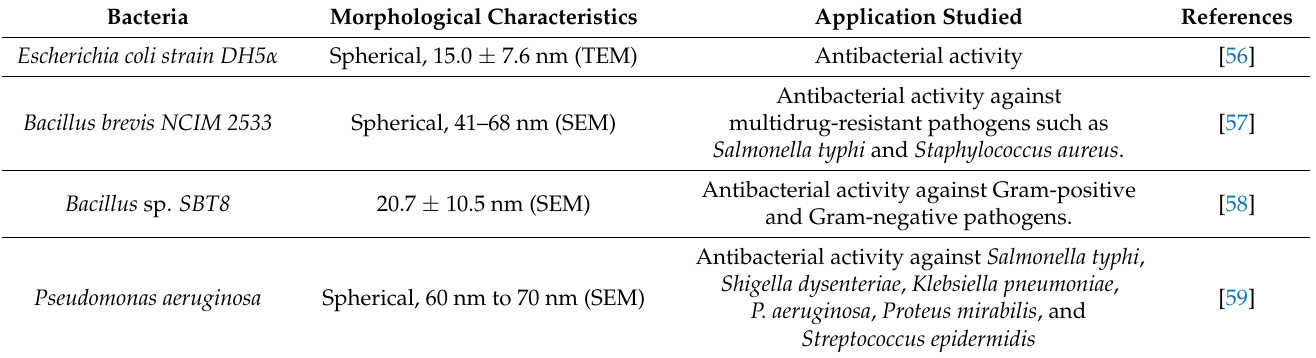
Table 1. Bacteria-mediated synthesis of AgNPs, their morphological characteristics, and their